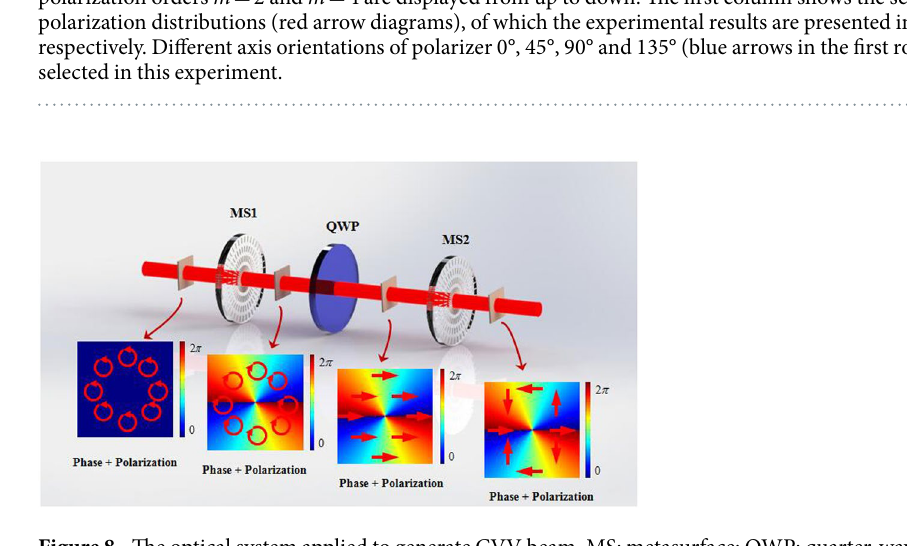
Figure 8. The optical system applied to generate CVV beam. MS: metasurface; QWP: quarter-wave plate. The first metasurface was used to generate RCP VB. The QWP was used for converting the RCP to horizontal linear polarization. The second metasurface was used to generate CVV beam by incident the horizontal linear polarization VB. Insets show the polarization and phase patterns in each step of this